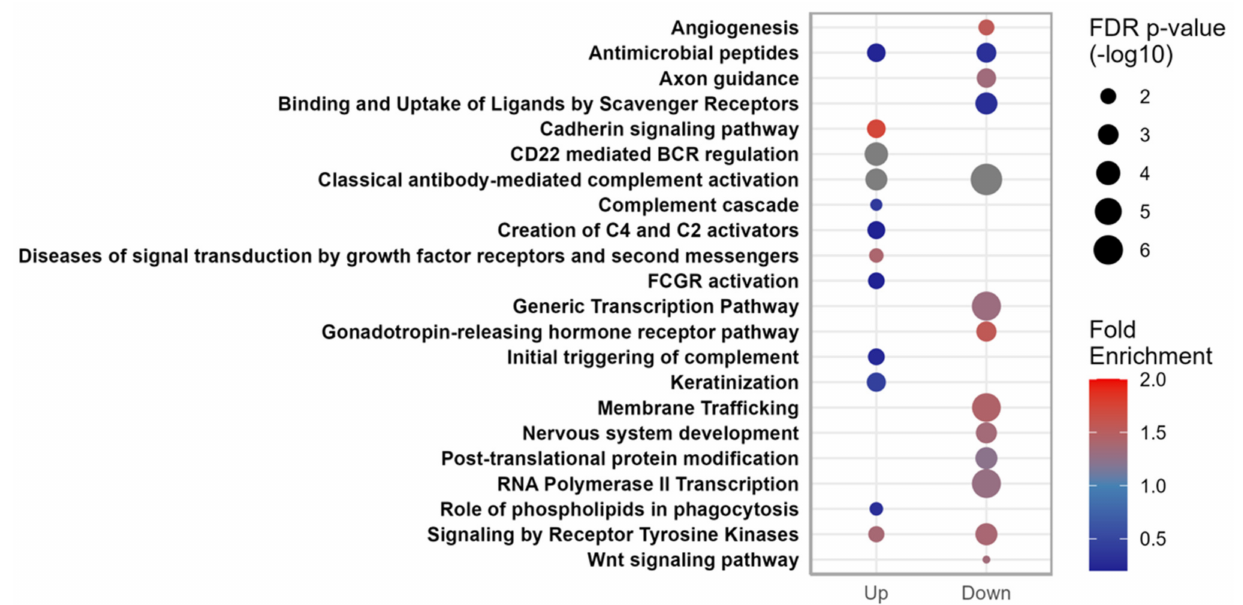
Figure 5. Overview of predicted pathway enrichments of the mRNA targets of the miRNAs signifi- cantly changed during FU, either upregulated or downregulated in PCOS patients. The color of the circles corresponds to the degree of positive fold enrichment, while the size of the circle corresponds to the false discovery rate (FDR) adjusted p